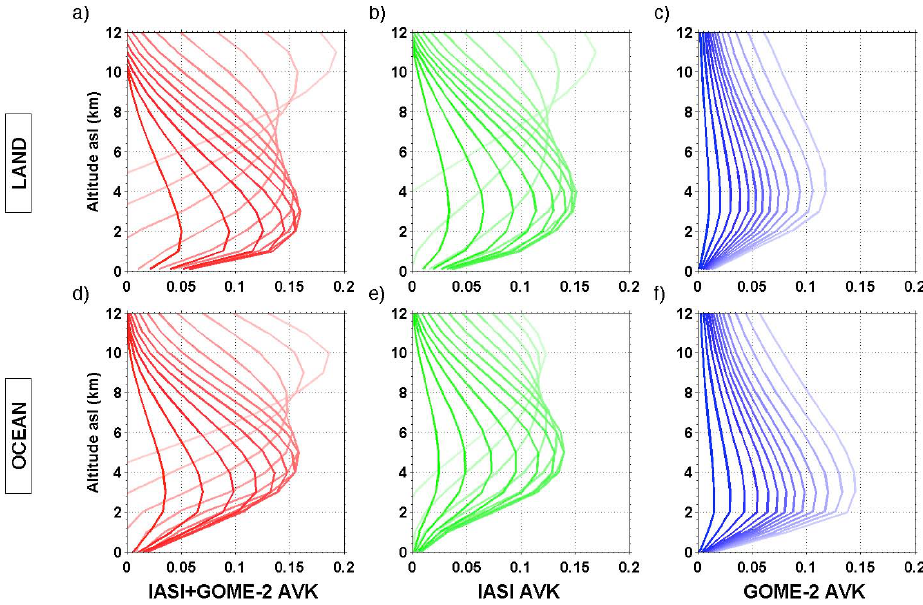
Fig. 4. Typical examples of AVKs between the surface and 12km a.s.l. for ( a and d ) IASI+GOME-2, ( b and e ) IASI only and ( c and f ) GOME-2 only ozone retrieval methods, over land (top) and over ocean (bottom). Lighter colours are given for AVK’s rows at higher